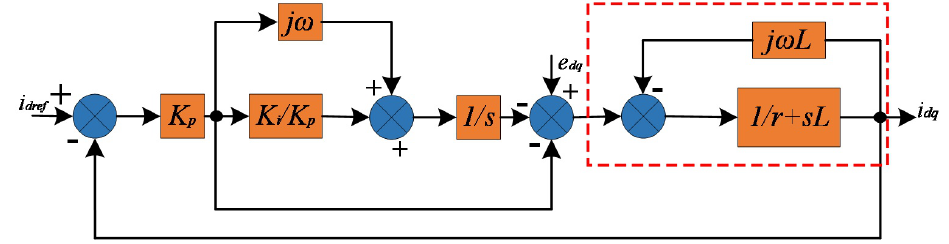
Figure 8. Complex vector decoupling control